Question: What form of chart is displayed?
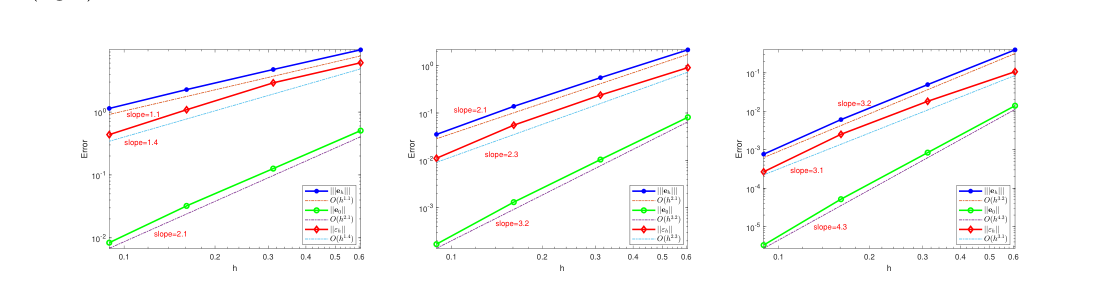
Answer: line